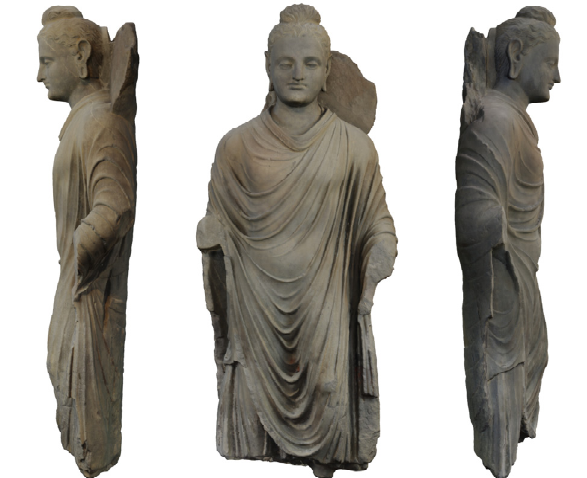
Figure 10 . Optimized 3D model of the Gandhāra Buddha derived from Metashape® software.